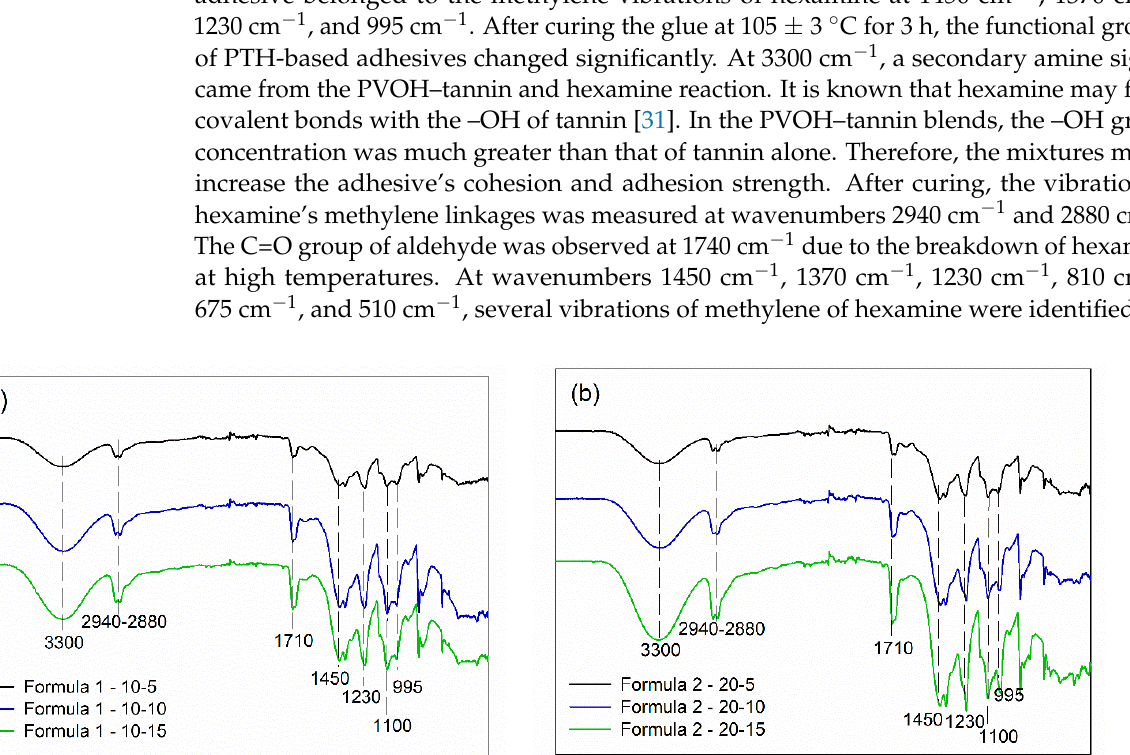
Figure 3. Flow behavior analysis of PVOH–tannin–hexamine-based adhesives. ( a ) Cohesion strength of Formula 1, ( b ) cohesion strength of Formula 2, ( c ) dynamic viscosity of Formula 1, ( d )